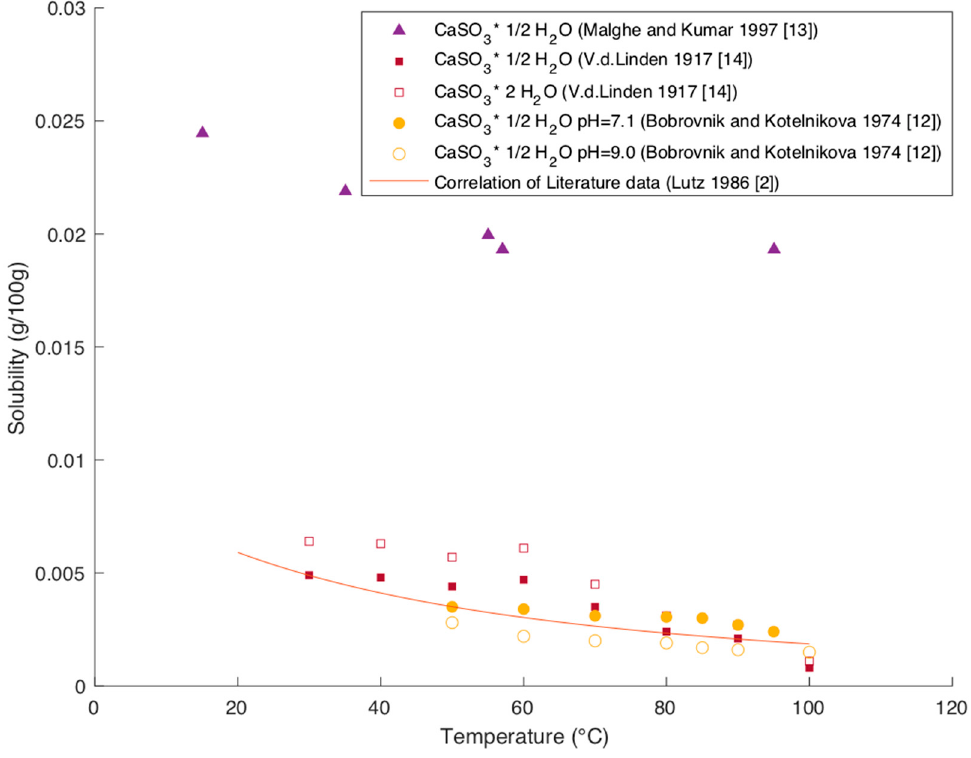
Figure 6. Solubility of Ca SO 3 in water